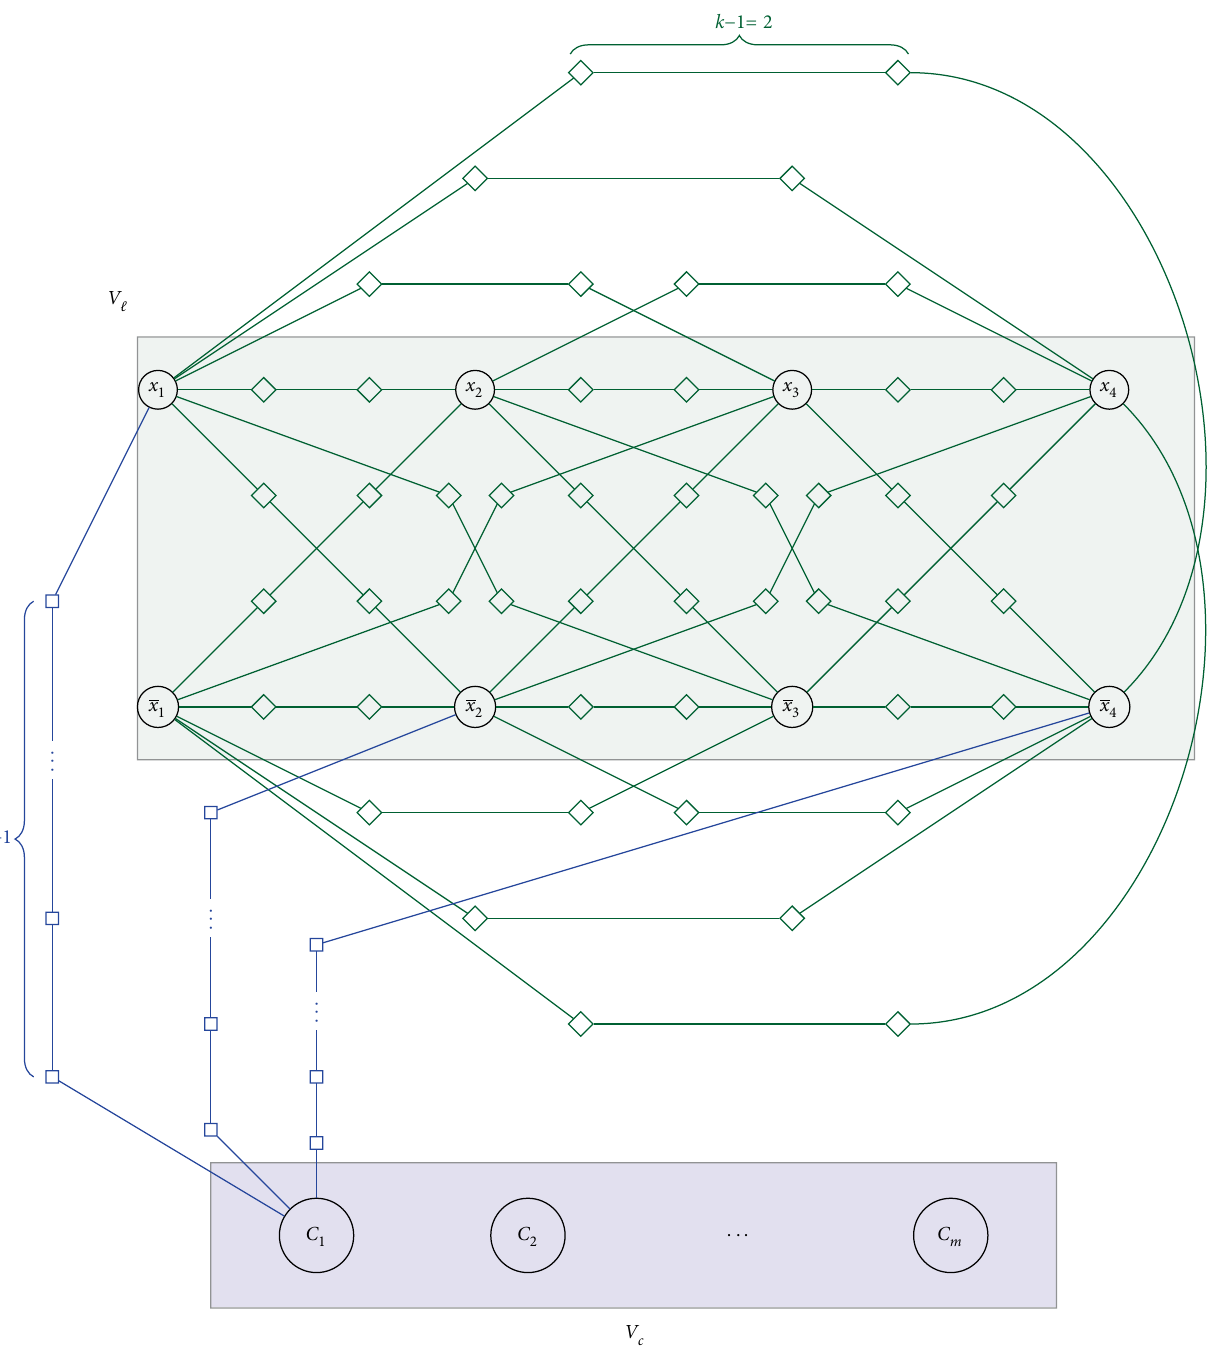
Figure 2: An example of the gadget used to reduce an instance of 3sat to our problem to an instance of our problem with 푘 = 3 . For simplicity, we only show one clause, 퐶 푀 − 1